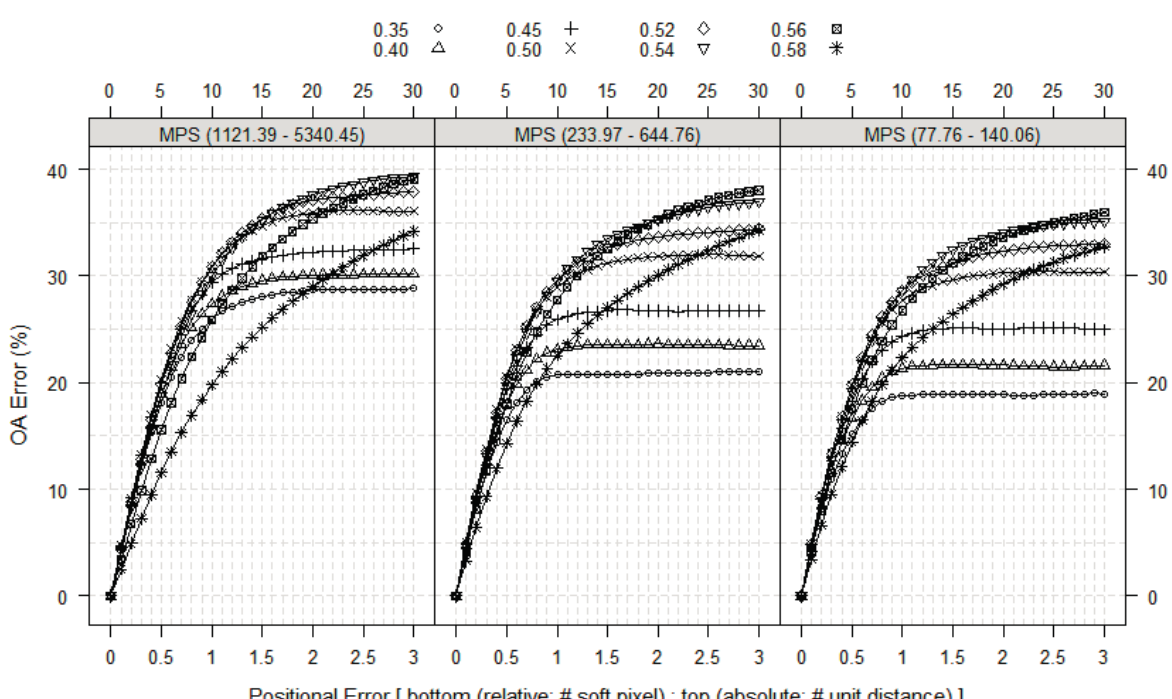
Figure 5. Impact of positional error on OA-error at different landscape characteristics using a spatial resolution of 5 unit distance.